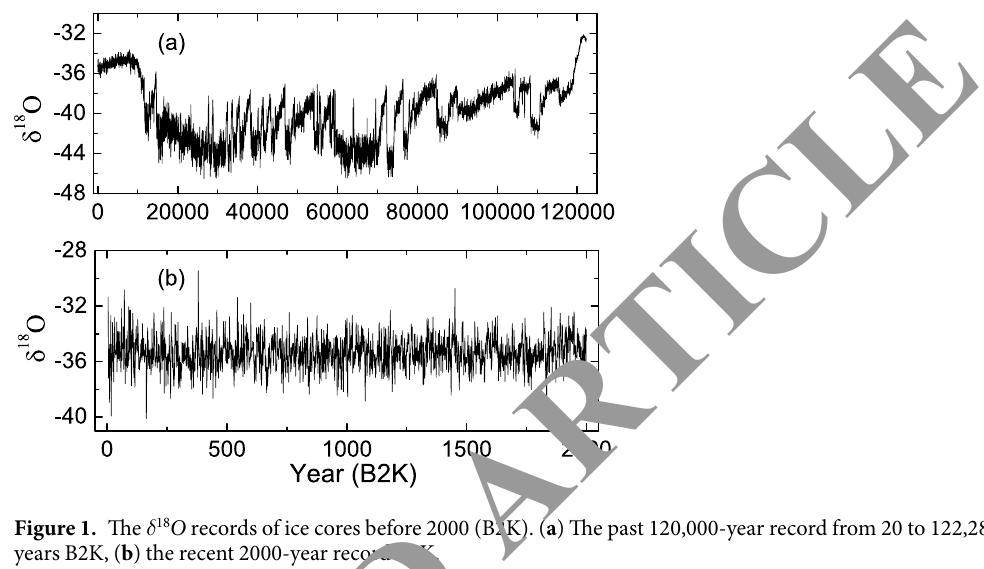
Figure 1. The δ 18 O records of ice cores before 2000 (B2K). ( a ) The past 120,000-year record from 20 to 122,280 years B2K, ( b ) the recent 2000-year record